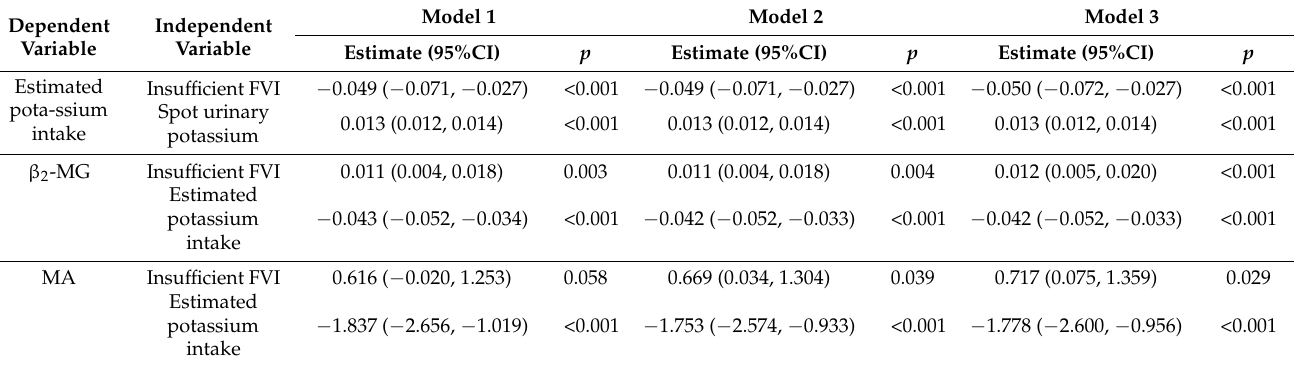
Table 2. Bivariate associations of renal damage indicators, FVI and potassium indicators using linear mixed effects models among 6–9 year old children, Beijing, China.